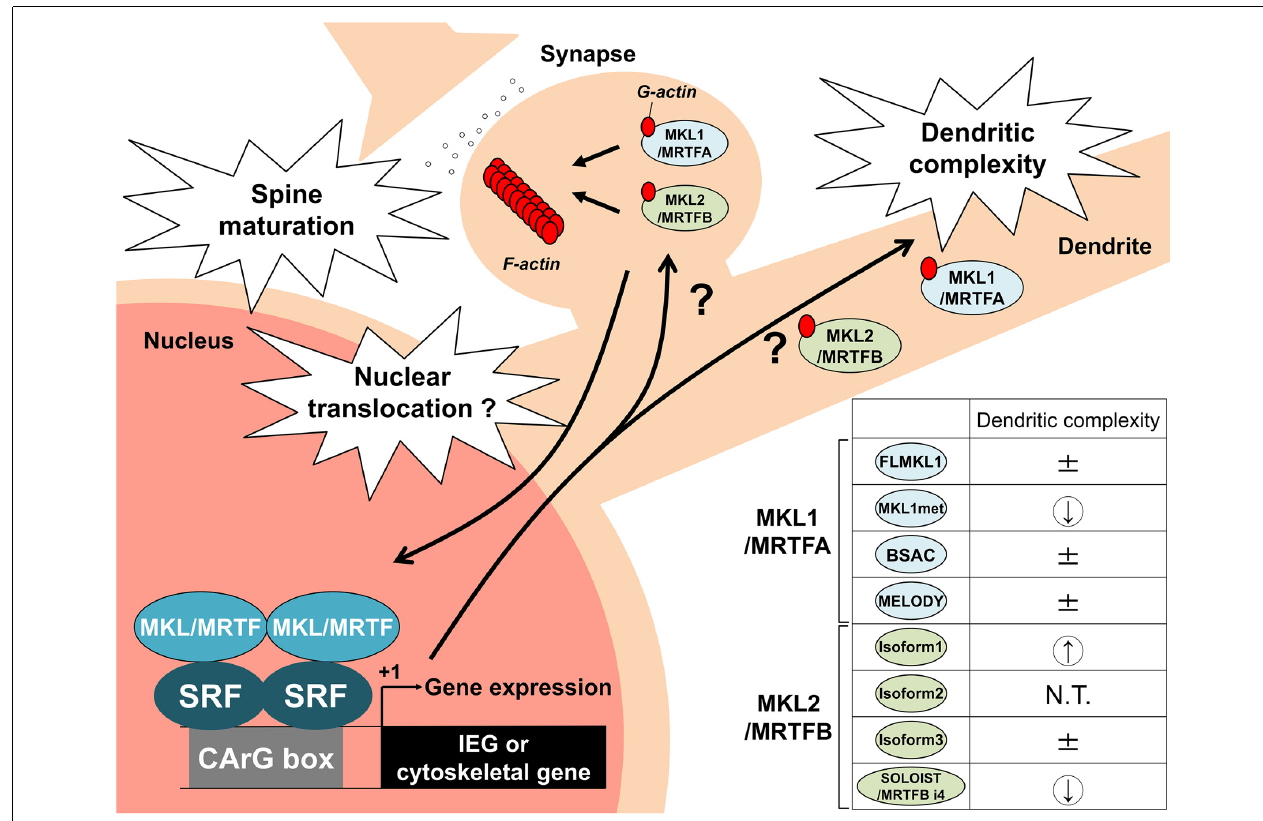
FIGURE 2 | Schematic model by which MKL/MRTF and its isoforms regulate neuronal morphology and transcription. MKL/MRTF is localized in dendrites and dendritic spines. MKL/MRTF is an actin-binding protein and SRF cofactor. MKL/MRTF might act locally in dendrites and dendritic spines as well as bind to SRF to regulate IEGs or cytoskeletal genes in the nucleus to modulate spine maturation and dendritic complexity. In addition, the generation of multiple MKL/MRTF isoforms might fine-tune neuronal morphology and gene transcription in neurons. The overexpression studies of MKL/MRTF isoforms in terms of dendritic complexity are summarized on the right side. ± indicates no change; a down arrow indicates a decrease in dendritic complexity, and an up arrow indicates an increase in dendritic complexity. N.T. indicates not tested. IEG, immediate early gene.